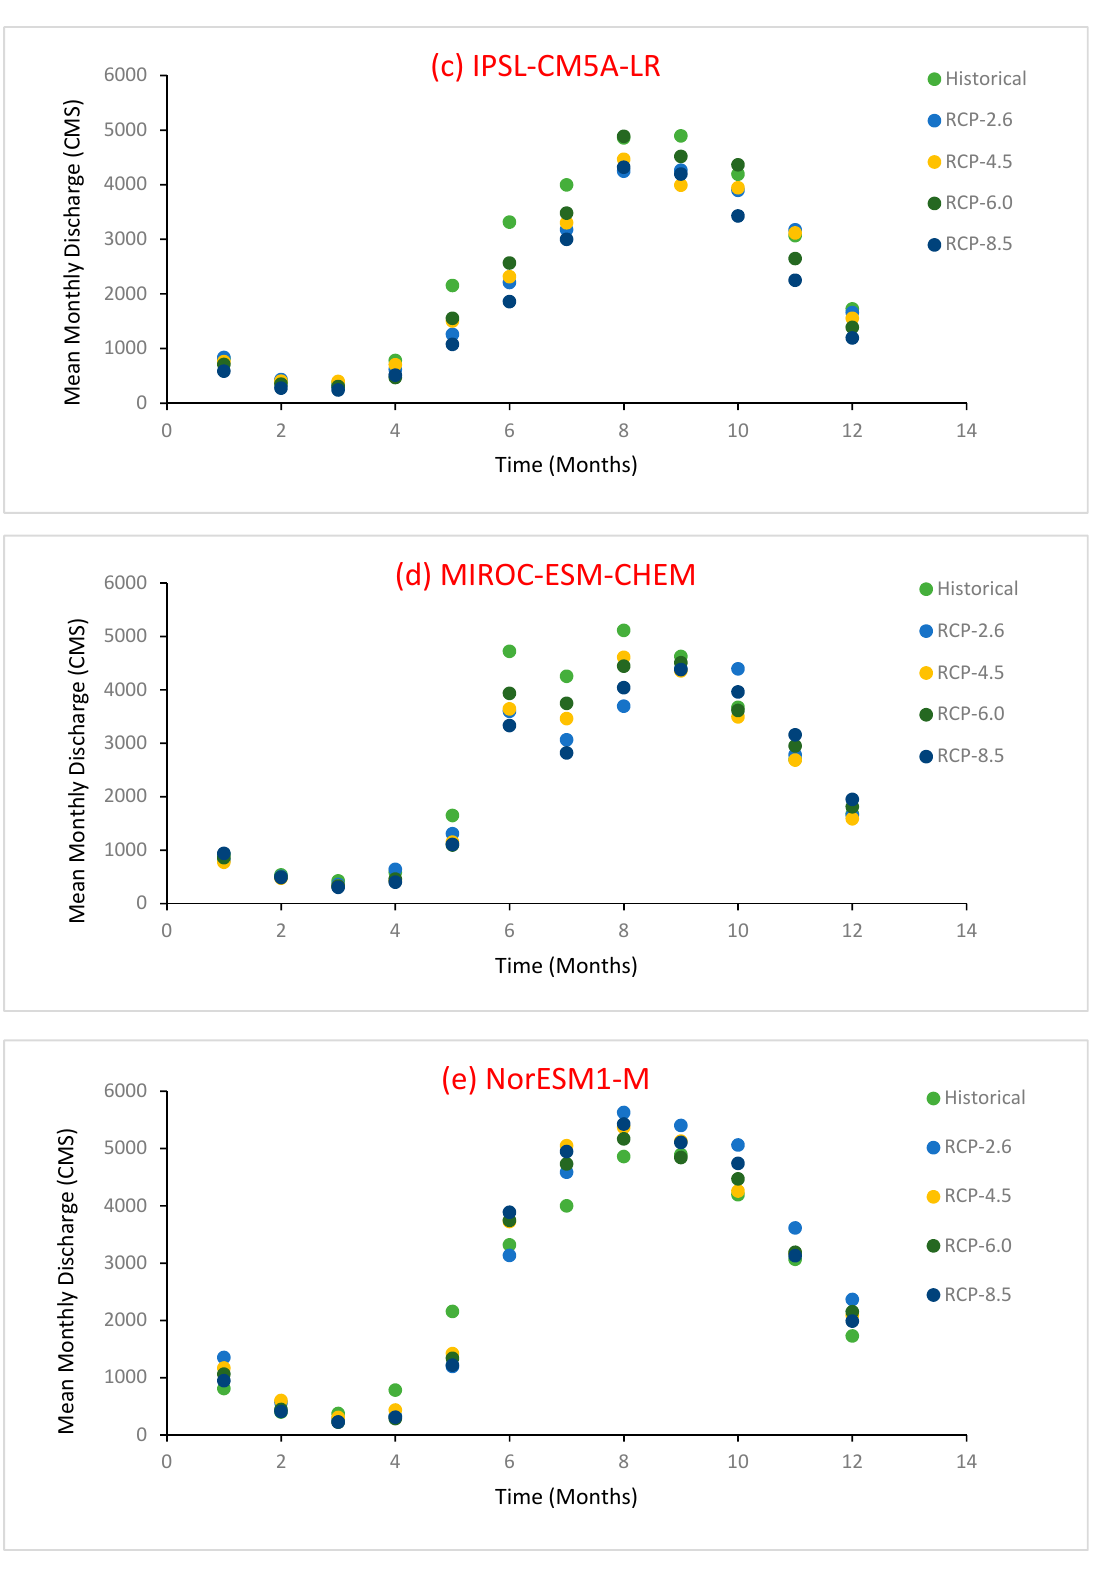
Figure6. Meanmonthlydischargeofhistoricalandfutureperiodsunderfouremissionscenariosforeach Figure 6. Mean monthly discharge of historical and future periods under four emission scenarios for globalclimatemodel: ( a )GFDL-ESM2M,( b )HadGEM2-ES,( c )IPSL-CM5A-LR,( d )MIROC-ESM-CHEM, each global climate model: ( a ) GFDL-ESM2M, ( b ) HadGEM2-ES, ( c ) IPSL-CM5A-LR, ( d ) MIROC- and ( e ) ESM-CHEM, and ( e ) NorESM1-M.